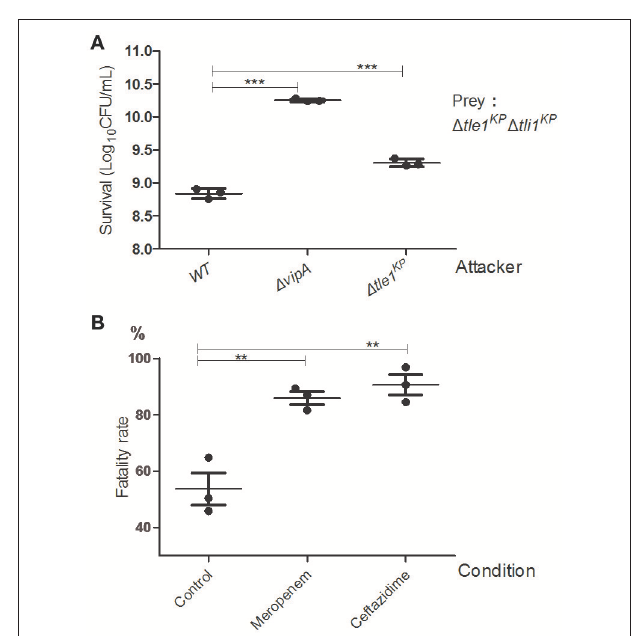
FIGURE 4 | Anti-bacterial activity of the HS11286 T6SS. (A) Intraspecies competition assays. Different strains were individually mixed with 1 tle1 KP 1 tli1 KP on LB medium and then viability on selective medium was determined. 1 tle1 KP 1 tli1 KP was the prey. (B) T6SS-dependent killing activity under antibiotic stress. The attacker strains (WT and 1 vipA ) were individually mixed with the prey strain ( 1 tle1 KP 1 tli1 KP ) on different antibiotic media and then titered for viable counts on selective media. The fatality rate was calculated based on viable cell count of the prey with or without competence. CFU competition / CFU control . The sub-inhibitory concentrations of meropenem (4 mg/L) and ceftazidime (32 mg/L). Control was added (ddH 2 O). Each group in (A,B) has three replications. ** P < 0.01; *** P < 0.001.